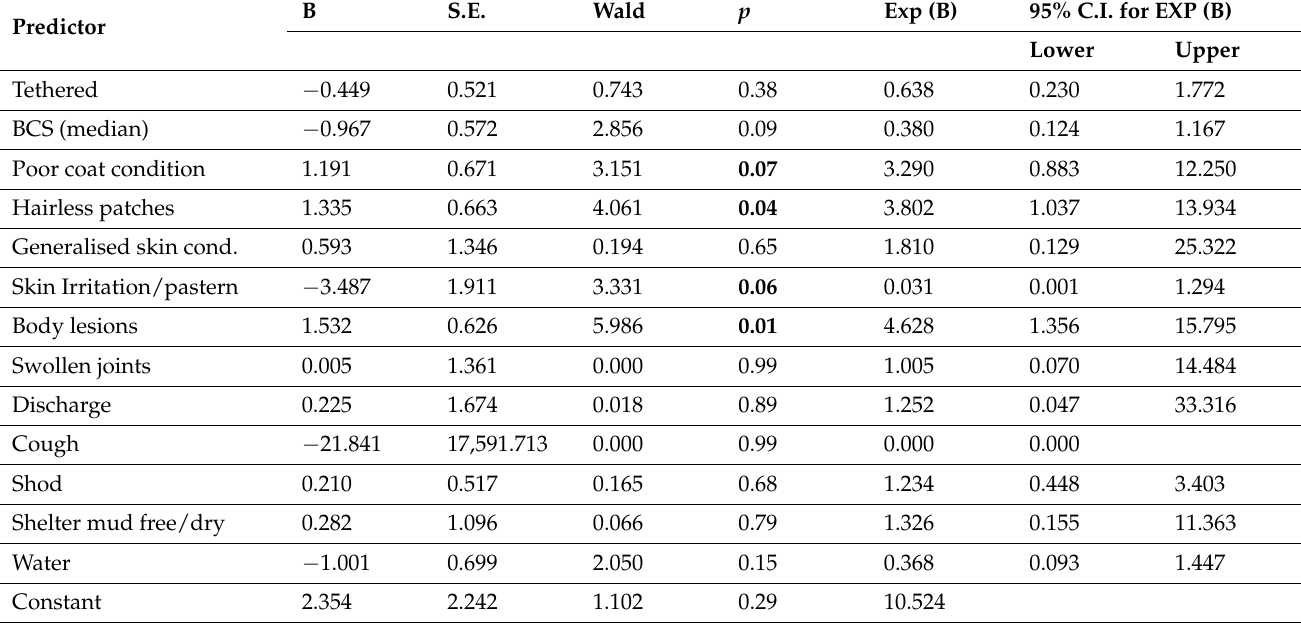
Table 5. Binomial logistic regression predicting likelihood of the presence of hoof cracks/breakages (0 = absent, 1 = present), ( n = 104). Significant results are bolded (p < 0.05), degrees of freedom = 1.